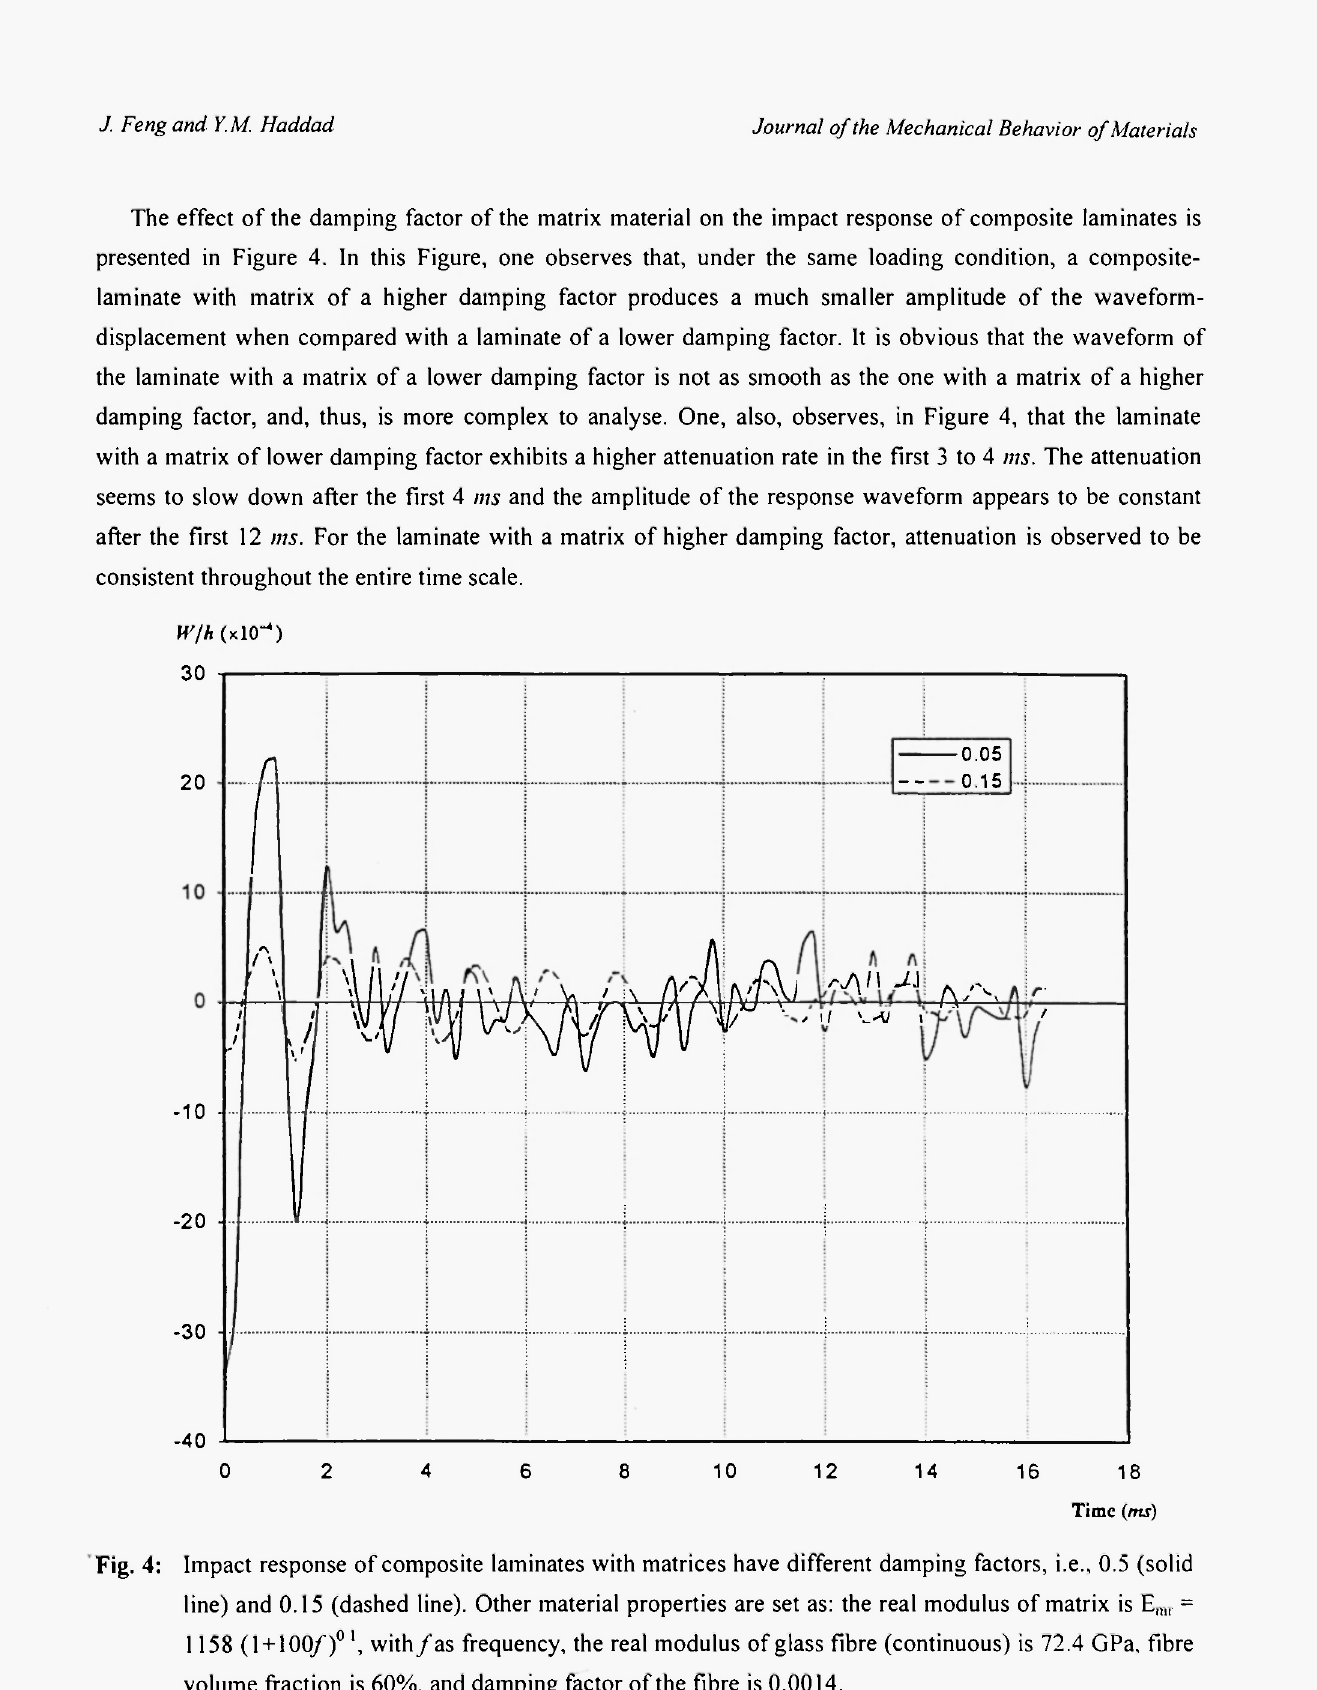
Fig. 4: Impact response of composite laminates with matrices have different damping factors, i.e., 0.5 (solid line) and 0.15 (dashed line). Other material properties are set as: the real modulus of matrix is E,„, = 1158 (1 + 100/)°', with/as frequency, the real modulus of glass fibre (continuous) is 72.4 GPa. fibre volume fraction is 60%, and damping factor of the fibre is